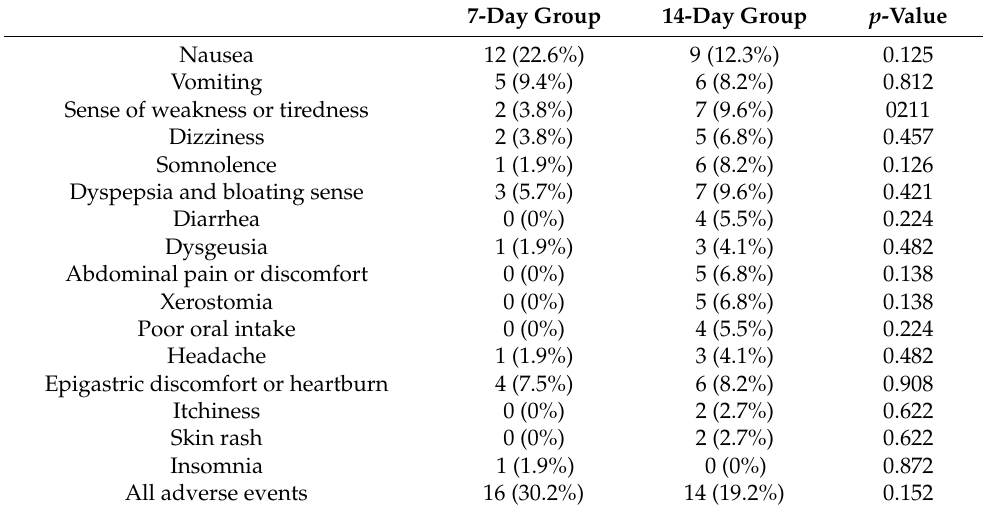
Table 5. The adverse event profile of the study